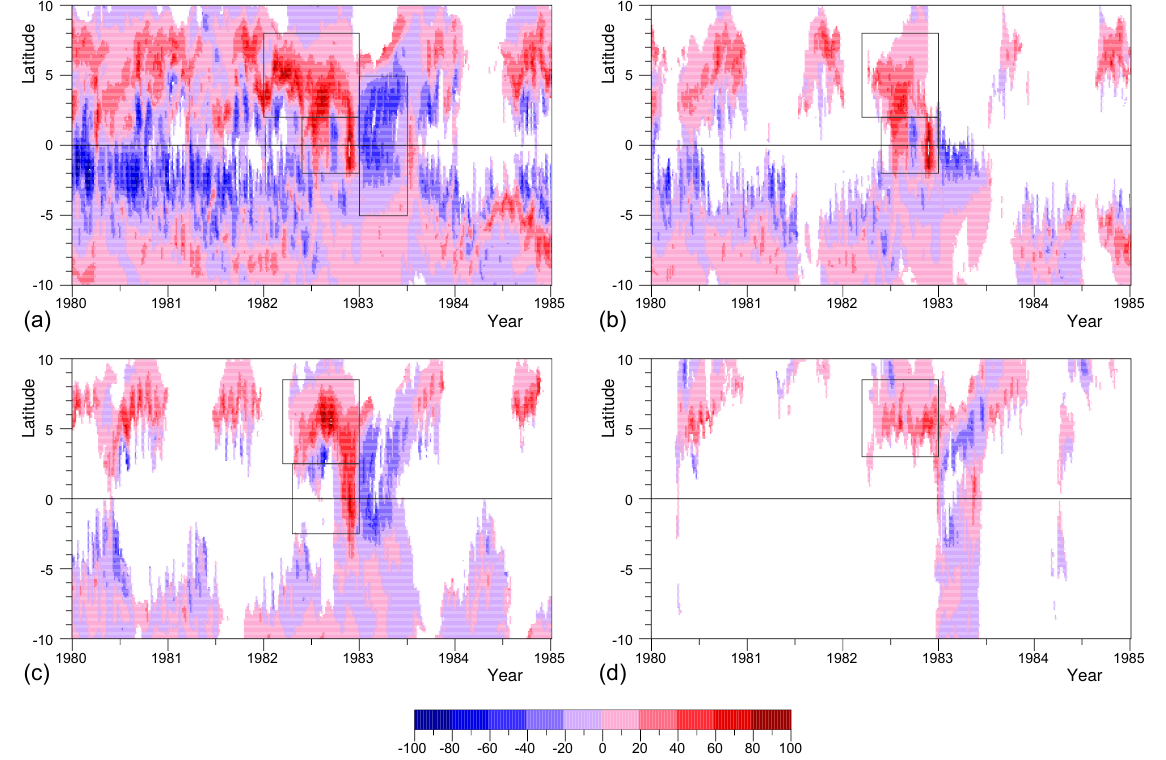
Figure 7. Vertically integrated flux of water (m 2 s − 1 ) with temperature (a) greater than 28 ◦ C crossing longitude 180 ◦ E, (b) greater than 29 ◦ C crossing 180 ◦ E, (c) greater than 28 ◦ C crossing 210 ◦ E and (d) greater than 28 ◦ C crossing 240 ◦ E. The figure is blank where the flux is zero. Rectangles enclose the regions of Table